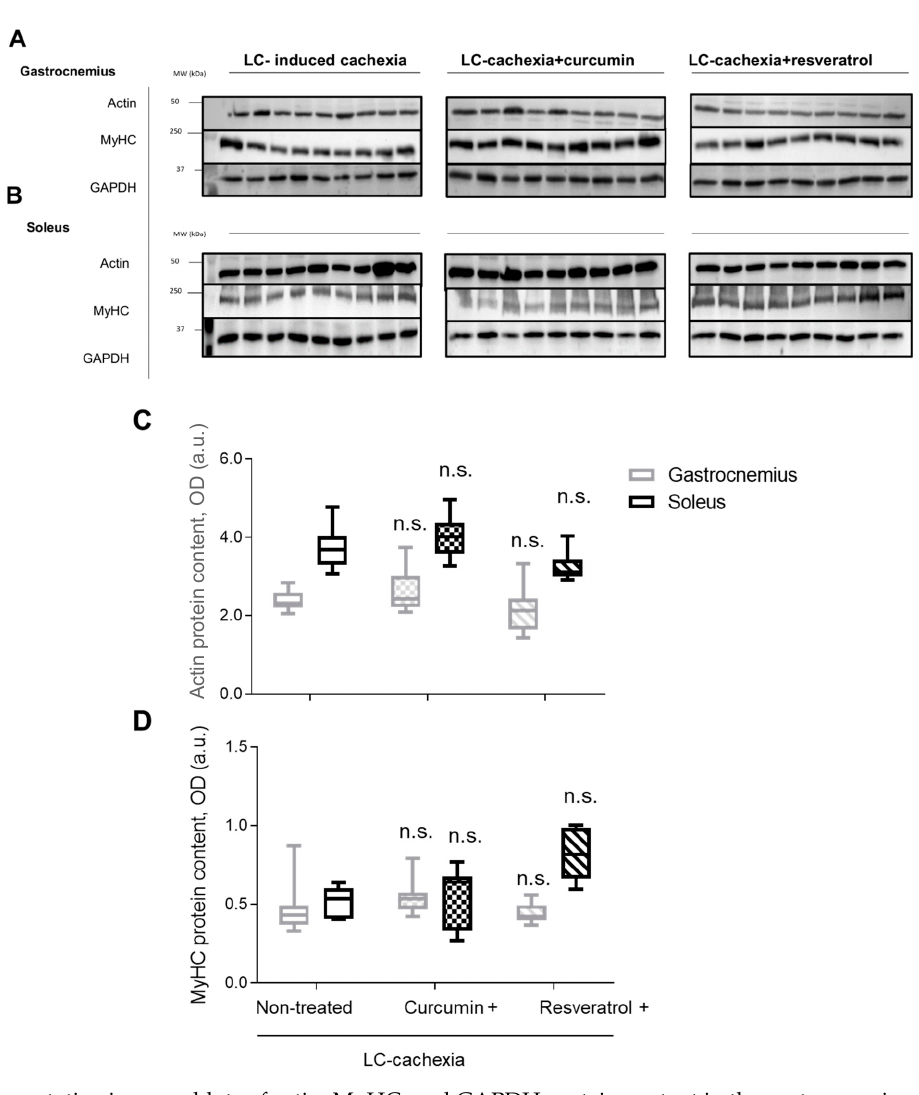
Molecules 2021 , 26 , x FOR PEER REVIEW 12 of